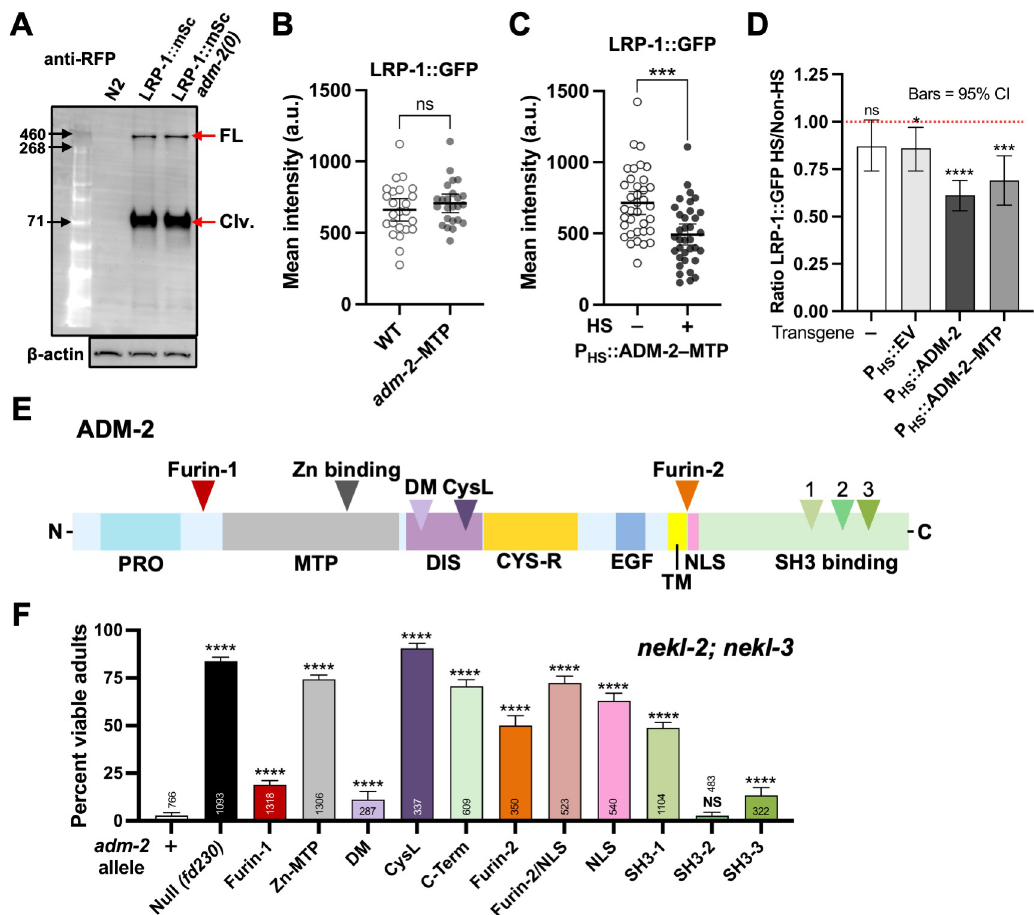
Fig 6. Regulation of molting by multiple ADM-2 domains. (A) Western blot showing RFP antibody recognizing the mScarlet tag in the endogenously expressed LRP-1::mScarlet protein. This blot shows the (From left) high molecular weight ladder, total protein lysates from Wild Type (N2), LRP-1::mScarlet and LRP-1::mScarlet; adm-2 ( fd300 ) strains. Full length (FL) protein and the cleaved cytoplasmic peptide (Clv.) shown in red arrows. Corresponding control blot recognizing β -actin is shown below. (B, C) Dot plots showing the LRP-1::GFP mean intensity (a.u.) within the apical plane of the worm hypodermis for each individual worm in; (B) Wild Type and adm-2 metalloprotease mutant background; (C) worms containing the P :: adm-2 hsp-16 (metalloprotease mutant) transgene in the absence of heat shock and after heat shock. In B and C, group means along with 95% confidence intervals (error bars) are indicated. p-Values were obtained by comparing means using an unpaired t-test: ��� p � 0.001; ns, p � 0.05. (D) Bar plot showing the ratio of LRP-1::GFP mean intensity in the absence of heat shock and after heat shock in the worms containing no transgene, P hsp-16 :: Empty Vector , P hsp-16 :: adm-2 and P hsp-16 :: adm-2(metalloprotease mutant) transgenes respectively. Error bars represent 95% confidence intervals. p-Values were obtained by comparing means in the absence of heat shock and after heat shock using an unpaired t-test: ���� p � 0.0001; ��� p � 0.001; ns, p � 0.05. (E) Schematic representation of predicted protein domains within ADM-2. PRO, prodomain; MTP, metalloprotease domain; DIS, disintegrin domain; CYS-R, cysteine repeat region; TM, transmembrane domain; NLS, predicted nuclear localization signal; DM, disintegrin motif; CysL, cysteine loop; SH3 binding (1–3) Src homology 3 binding domains. (F) Percentage of viable (non-molting-defective) nekl-2; nekl-3 adults in the indicated CRISPR-derived adm-2 mutant backgrounds. Error bars represent 95% confidence intervals. p-Values were determined using Fisher’s exact test: ���� p � 0.0001; ns, not significant. Raw data for this figure is provided in S1